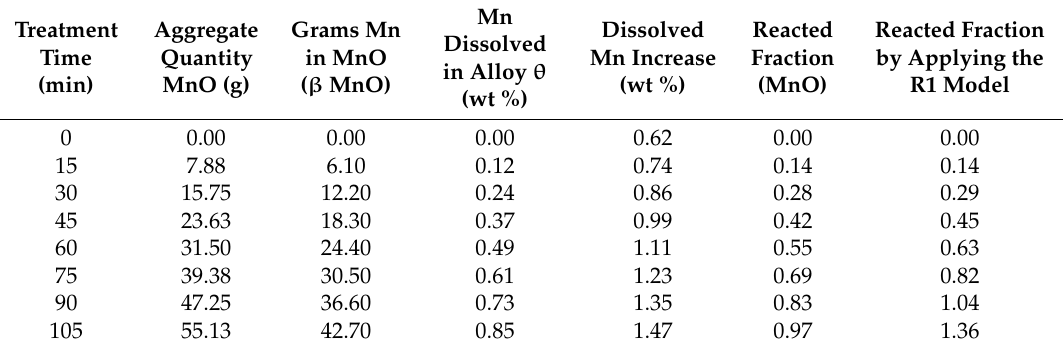
Table 5. Data calculated for the simulation of the quantities of Mn that would provide MnO for each addition made, according to the time of